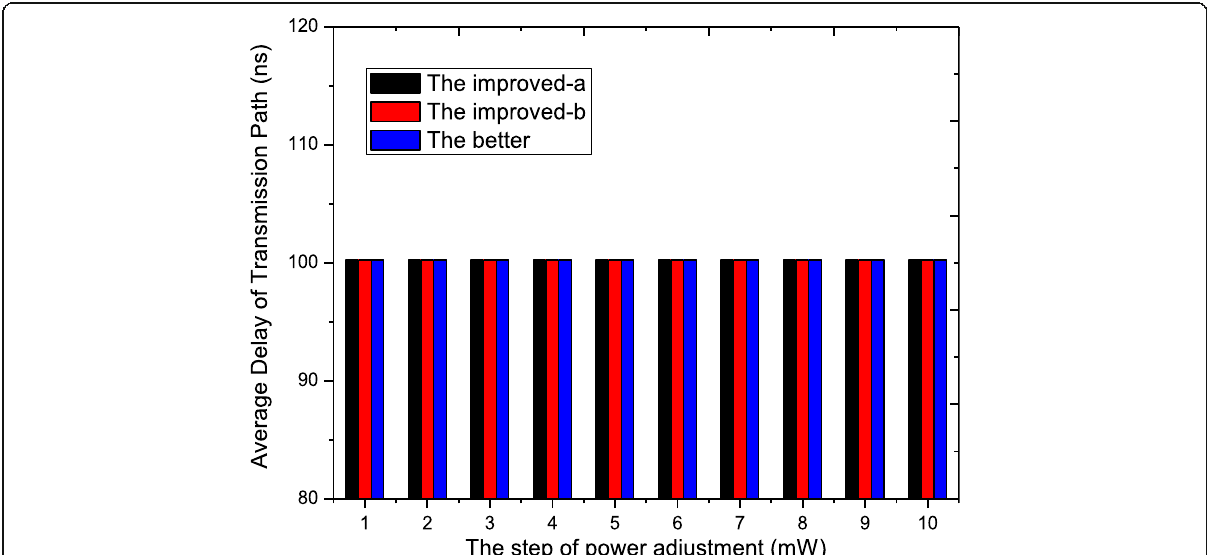
Fig. 15 Delay performance comparison: variation trend of delay of TOM-PAOD with the step size for power adjustment, in which the different game decision algorithms are adopted respectively